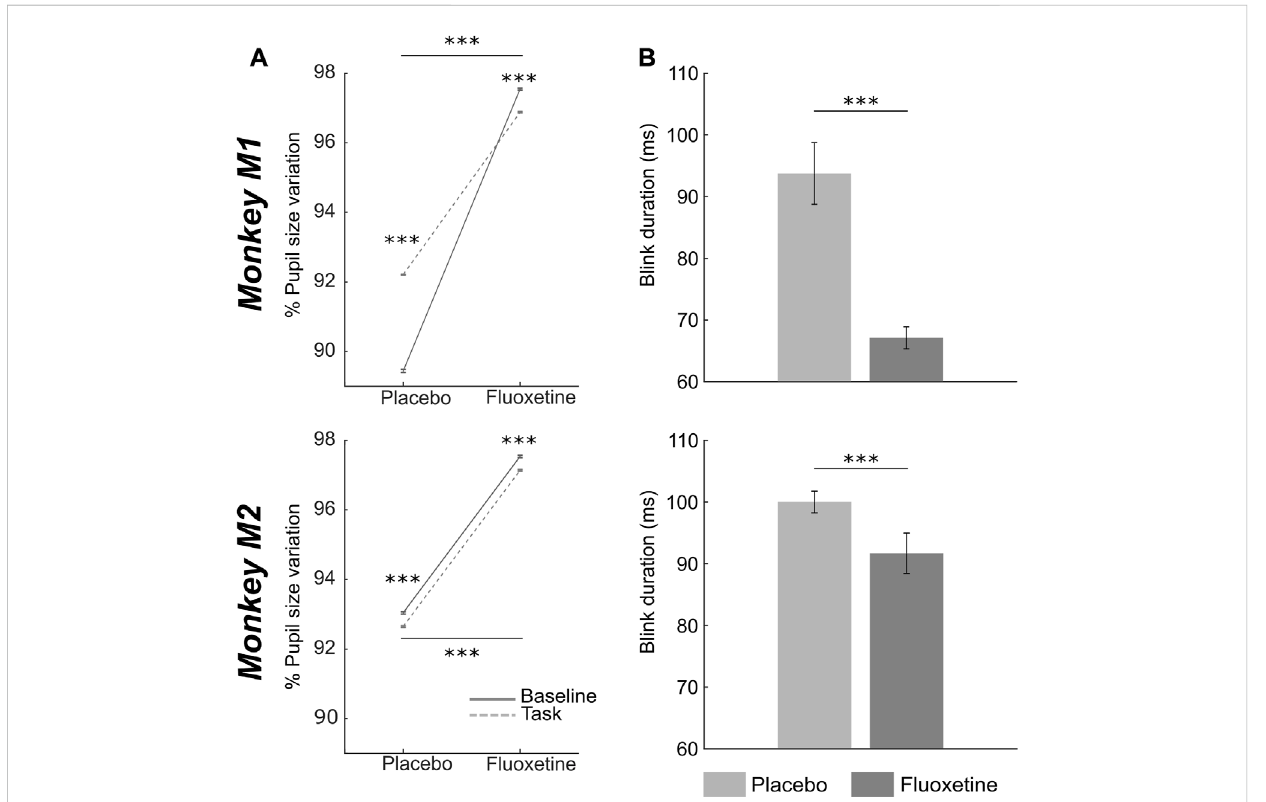
FIGURE 5 Effect of fl uoxetine on pupil size and eye blink duration. (A) Median+/-median absolute error of %pupil size changes relative to the entire task, for monkeys M1 (top)and M2 (bottom), during rest (baseline, continuous line) and after target presentation (task, dashed lines), in the placebo and fl uoxetine conditions. (B) Median+/-median absolute error of blink duration, for monkeys M1 (top) and M2 (bottom), in the placebo and fl uoxetine conditions. Statistical signi fi cance is represented as follows: ***, p < 0.001; **, p < 0.01; *, p < 0.05. See also companion Supplementary Table S6 for detailed